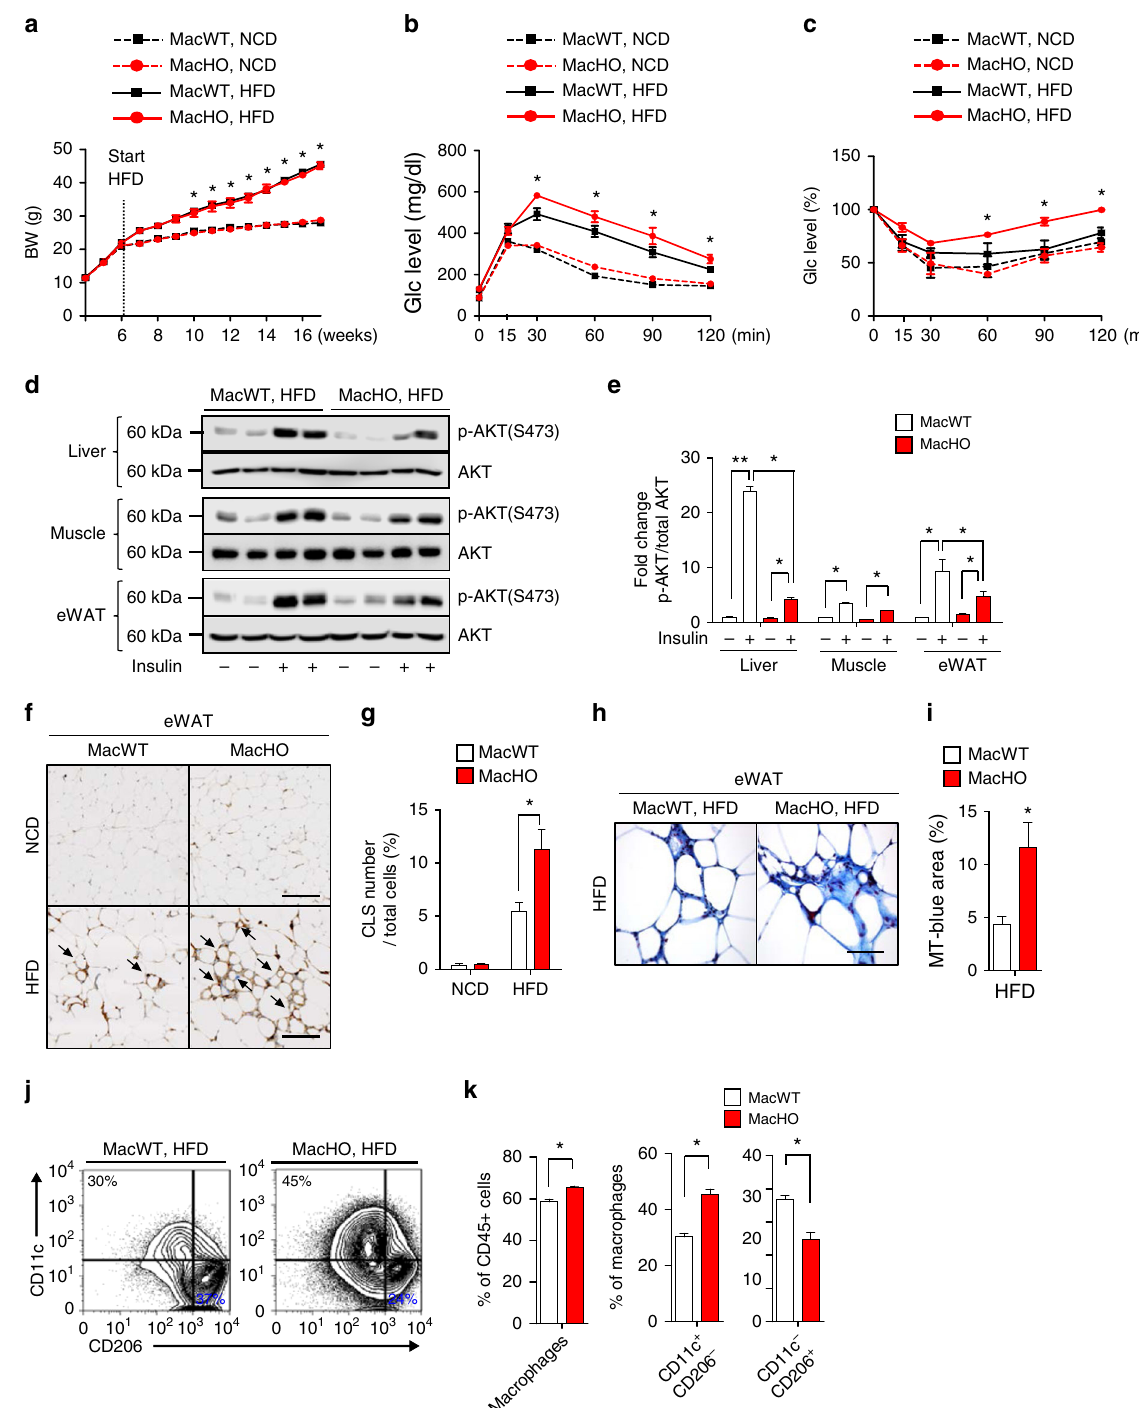
Fig. 2 MacHO mice fed a HFD exhibit systemic insulin resistance. ( a ) Body weight of MacWT and MacHO mice fed a NCD or HFD for 10 weeks (MacWT, n = 5; MacHO, n = 5). b , c MacWT or MacHO mice fed a NCD or HFD were subjected to IPGTT after a 16 h fast and an insulin tolerance test after a 4 h fast (MacWT, n = 5; MacHO, n = 5). d , e Immunoblot analysis of AKT (S473) phosphorylation in liver, muscle, and eWAT 30 min after intraperitoneal injection of insulin into MacWT or MacHO mice fed a HFD. f , g Immunohistochemical analysis (staining with an anti-F4/80 antibody and hematoxylin) of macrophages in eWAT of MacWT or MacHO mice fed a HFD. Scale bar: 200 μ m. h , i Masson ’ s trichrome staining (for fi brosis) of eWAT from MacWT or MacHO mice fed a HFD. Scale bar: 50 μ m. ( j and k ) FACS analysis of total macrophages (CD45 + /F4/80 + /CD11b + ) and M1 (CD11c + /CD206 - ) and M2 (CD11c − /CD206 + ) macrophages in fi ltrated into eWAT of MacWT or MacHO mice fed a HFD. Data represent means± SEM and are representative of three independent experiments. * p < 0.05 or ** p < 0.01 (two-tailed Student ’ s t